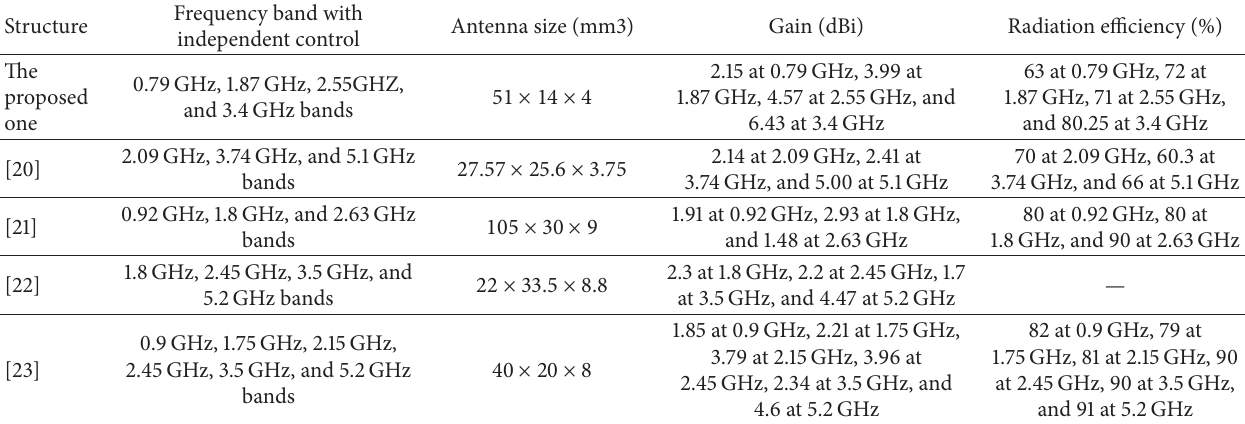
Table 1: Comparison of the proposed PIFA with other literature PIFAs with independent control of frequency bands. Structure The